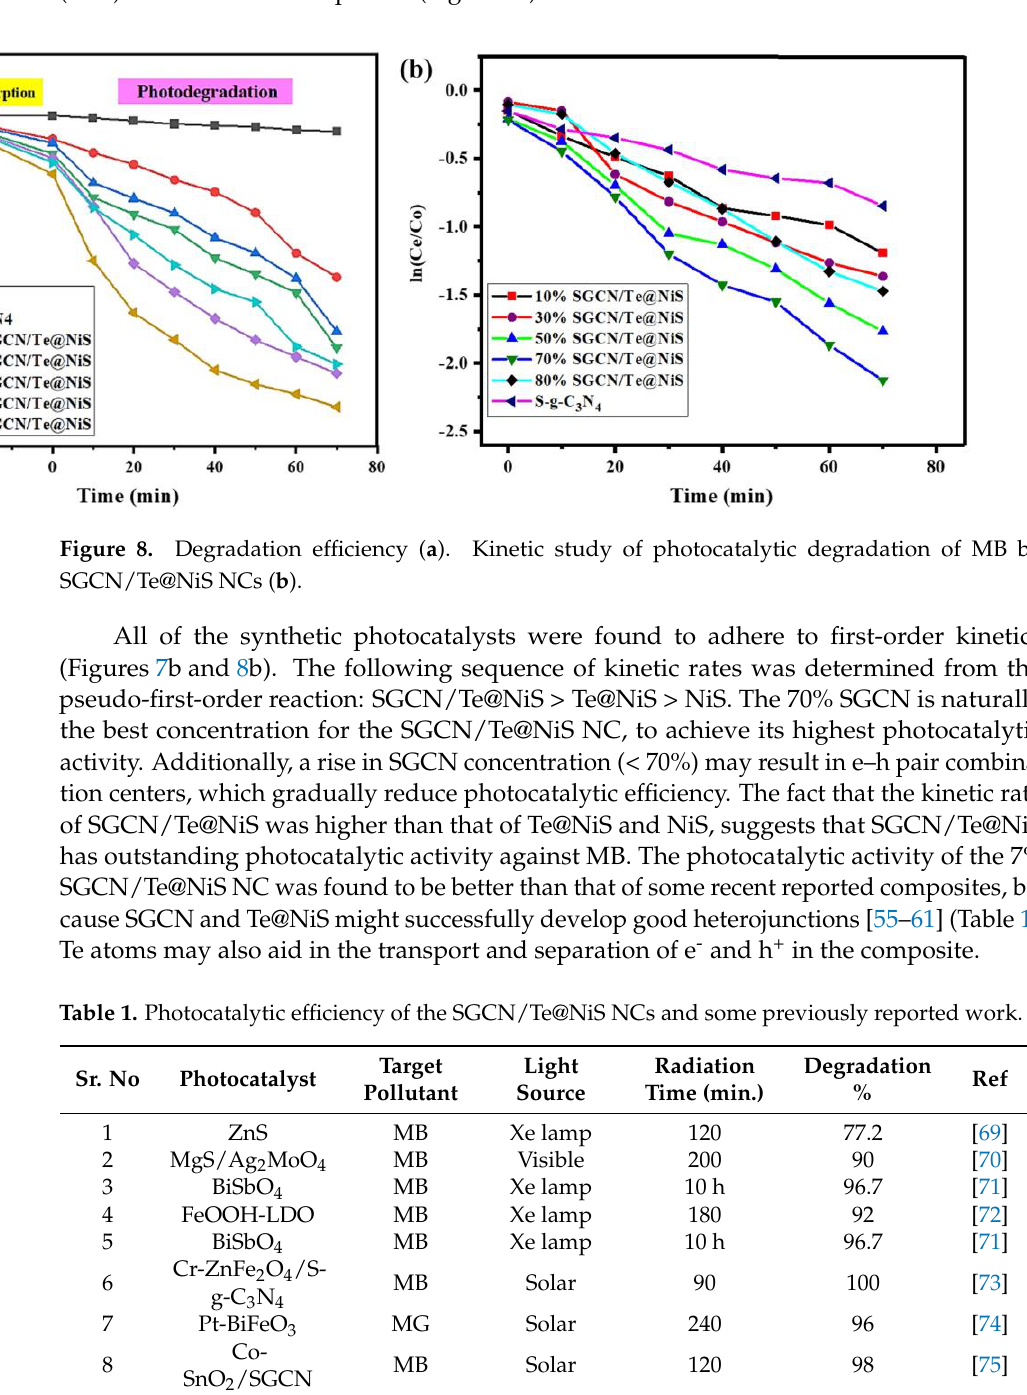
Table 1. Photocatalytic efficiency of the SGCN/Te@NiS NCs and some previously reported work. Sr.